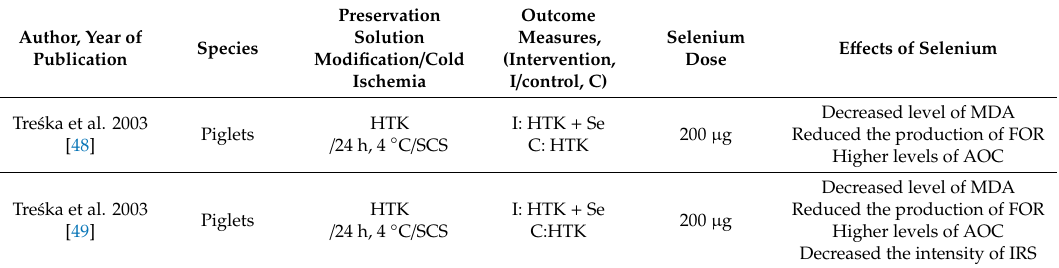
Figure 5. Proposition of the mechanism of prolactin action in the metabolic reduction of selenite (SO 32 − ) during ischemia / reperfusion. GSH, reduced glutathione; GSSG, oxidized glutathione; GS-Se-SG, selenodiglutathione; GS-SeH, glutathioselenol; Se 2 − , selenide; PRL, prolactin; GCL, glutamate cysteine ligase; Glu, Glutamate; Cys, Cysteine; Gly, Glycine; γ -GluCys, γ -Glutamyl-cysteine; AP-1, activator protein-1; NADPH, nicotinamide adenine dinucleotide phosphate; NADP + , oxidized form of the electron donor nicotinamide adenine dinucleotide phosphate. Table 1. E ff ect of the addition of selenium on the e ff ectiveness of the preservation